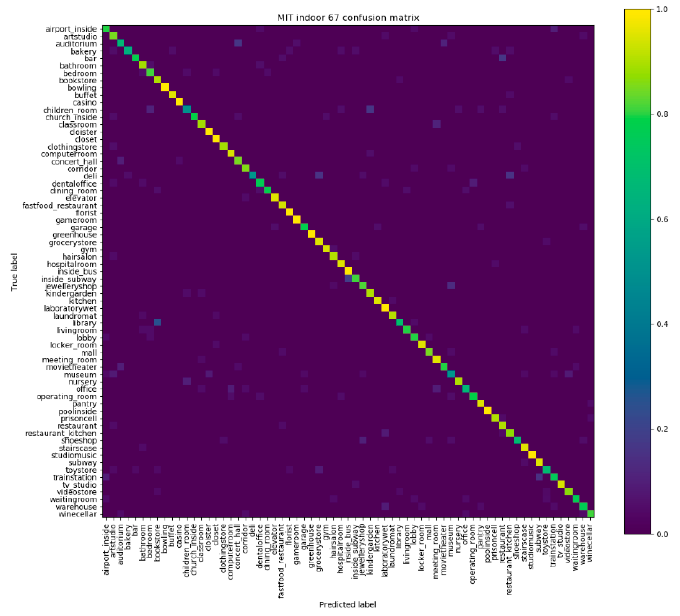
Figure 7. Confusion matrix of MIT indoor 67 dataset.